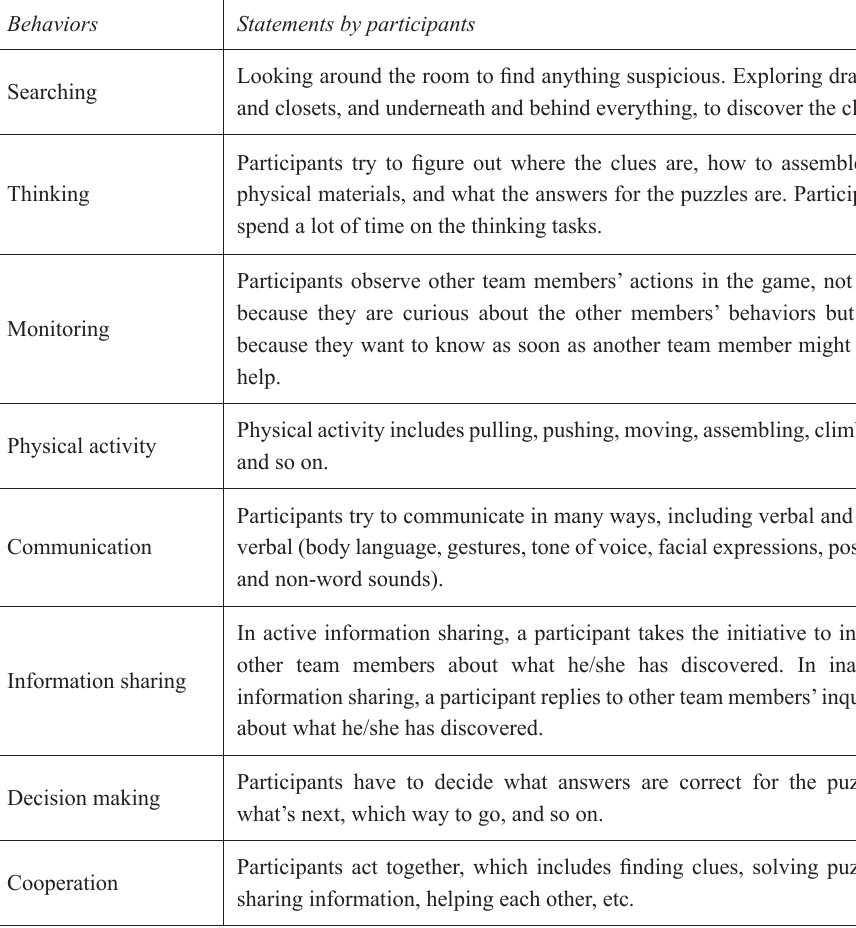
Table 9. Summary table of participant behaviors of escape room design (N. of group =